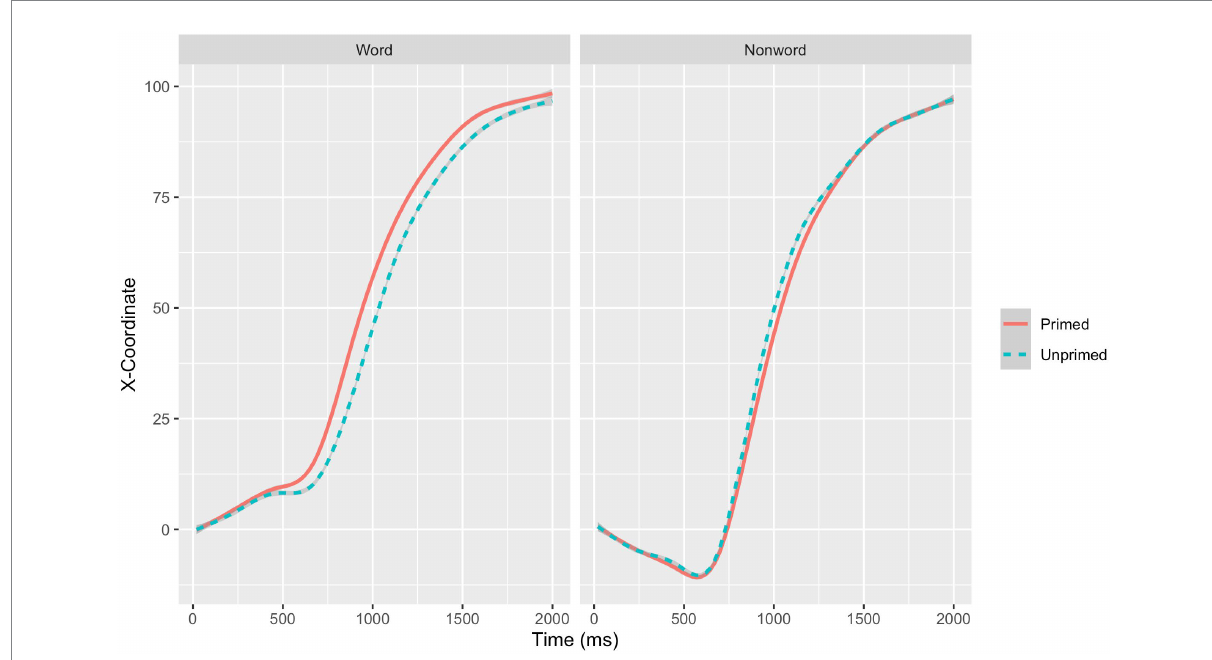
FIGURE 1 The initial 2,000 ms of the mouse trajectories for primed and unprimed words and nonwords in Experiment